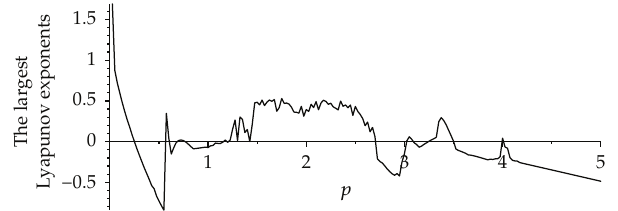
Figure 6: The largest Lyapunov exponents (cid:5) LLE (cid:6) corresponding to Figure 3.